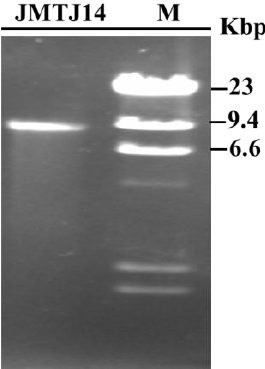
Figure 1. Agarose gel electrophoresis of dsRNA isolated from strain JMTJ14 of S. sclerotiorum . The dsRNA segment was treated with DNase I and S1 nuclease prior to fractionation on a 1.0% agarose gel (lane JMJT14). The size of the dsRNA was estimated using DNA size markers generated by digestion of λ DNA with Hin d III (lane M).